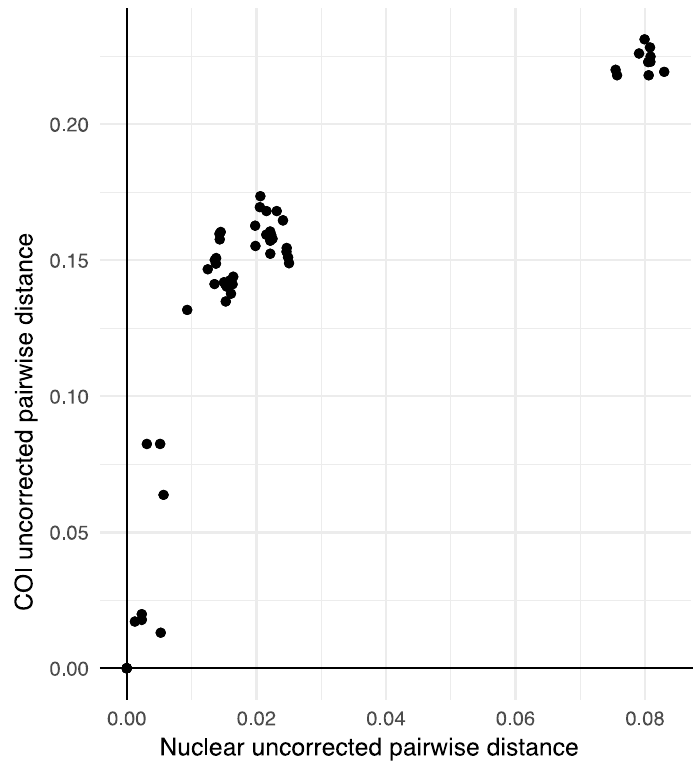
Figure 2. A scatter plot of uncorrected pairwise distances of COI versus uncorrected pairwise nuclear divergence for each whitefly specimen analyzed.